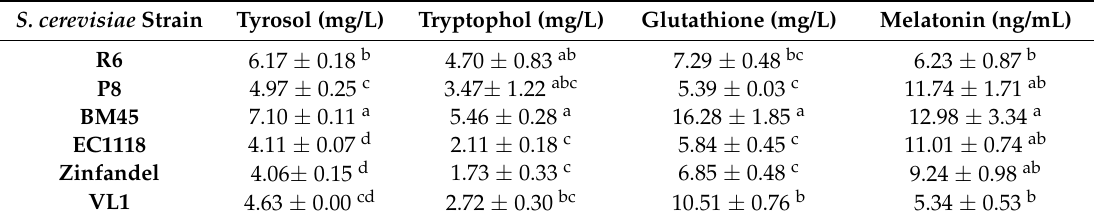
Table 2. Bioactive compounds quantified at the end of alcoholic fermentation carried out in synthetic must by different S. cerevisiae